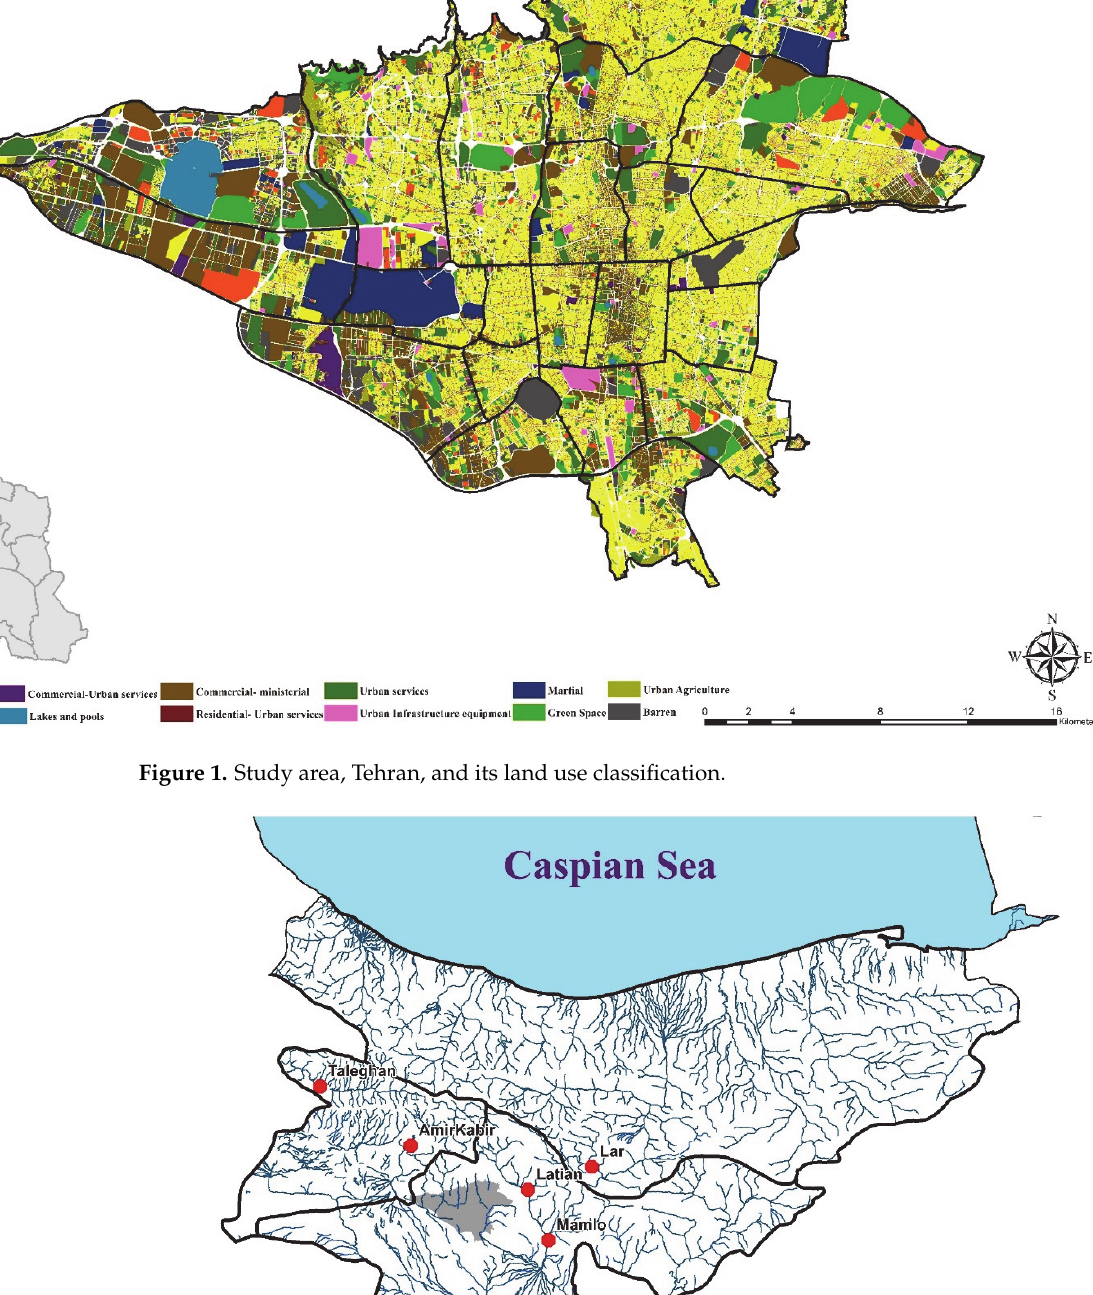
Table 2. Water resources of Tehran city and the percentage of participation in Tehran’s water supply [43].